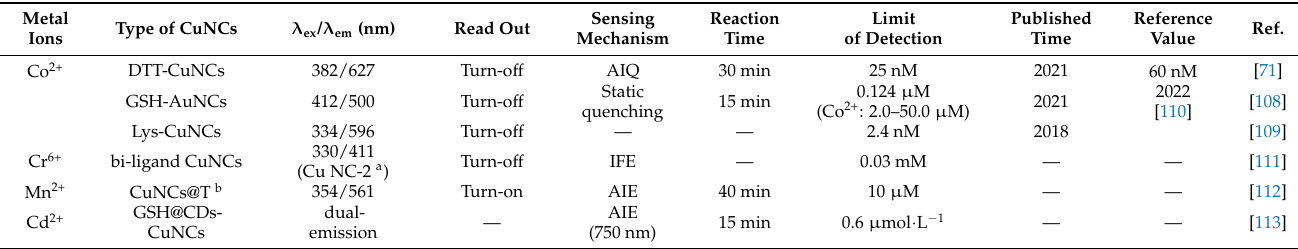
Table 4. The list reported HMIs detection via